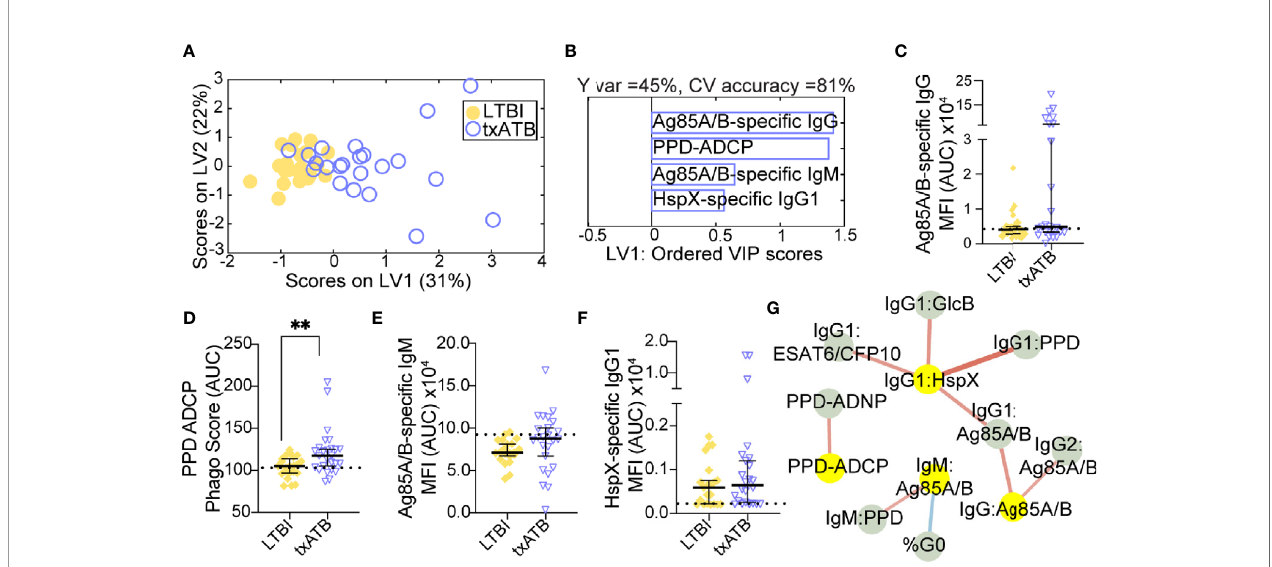
FIGURE 3 | TB-speci fi c IgG titers distinguish LTBI and txATB individuals. An OPLSDA models was constructed using the LASSO-selected features to discriminate LTBI and txATB (A, B) . The variance in the direction of separation of LTBI and txATB was condensed on LV1 (Y variance = 45%). 5-fold cross validation was performed, resulting in 81% CV accuracy. Permutation testing was performed, which showed that this model performed signi fi cantly better than models based on shuf fl ed group labels (Wilcoxon p=0.002). (A) OPLSDA scores plot depicts separation of LTBI (n = 21, yellow dots) and txATB (n-23, periwinkle open dots). LV1 and LV2 account for 31% and 22% of the variability in the input features. (B) VIP scores plot of top features providing the greatest resolution of LTBI and txATB in rank- order. Directions of the bars signify loadings on LV1 and colors represent the disease groups in which measures were enriched Pairwise comparison of LTBI (n = 21, yellow dots and diamonds) and txATB (n=23, periwinkle dots and triangles) individuals. (C) AUC Ag85A/B-speci fi c total IgG titers. (D) PPD-speci fi c ADCP Phago Score (E) AUC Ag85A/B-speci fi c IgM titers (F) AUC HspX-speci fi c IgG1 titers. Univariate plots (C – F) shows median and interquartile range of LASSO-selected features and statistically signi fi cant differences of the LASSO-selected features between LTBI and txATB groups calculated using Mann-Whitney test: **p < 0.01. The dotted lines represent median of healthy controls (G) Correlation analysis depicts other features that are positively (red lines) or negatively (blue lines) correlated with these four key features selected with LASSO (highlighted in yellow). Edges between nodes are weighted using signi fi cant correlation coef fi cients after correcting for multiple comparisons (Benjamini-Hochberg q-value < 0.05, testing the hypothesis of zero correlation). Only correlations with corrected p-values < 0.05 were